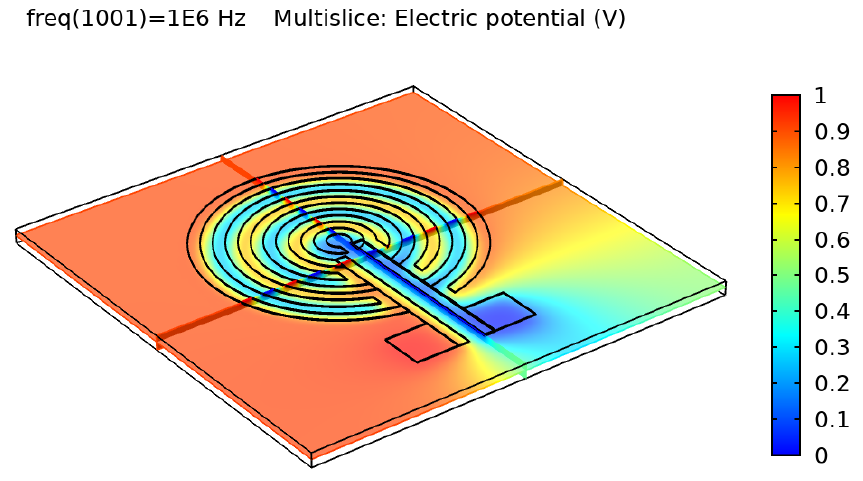
Figure 4. Electric distribution (V) in 3D mode for the circular IDE.